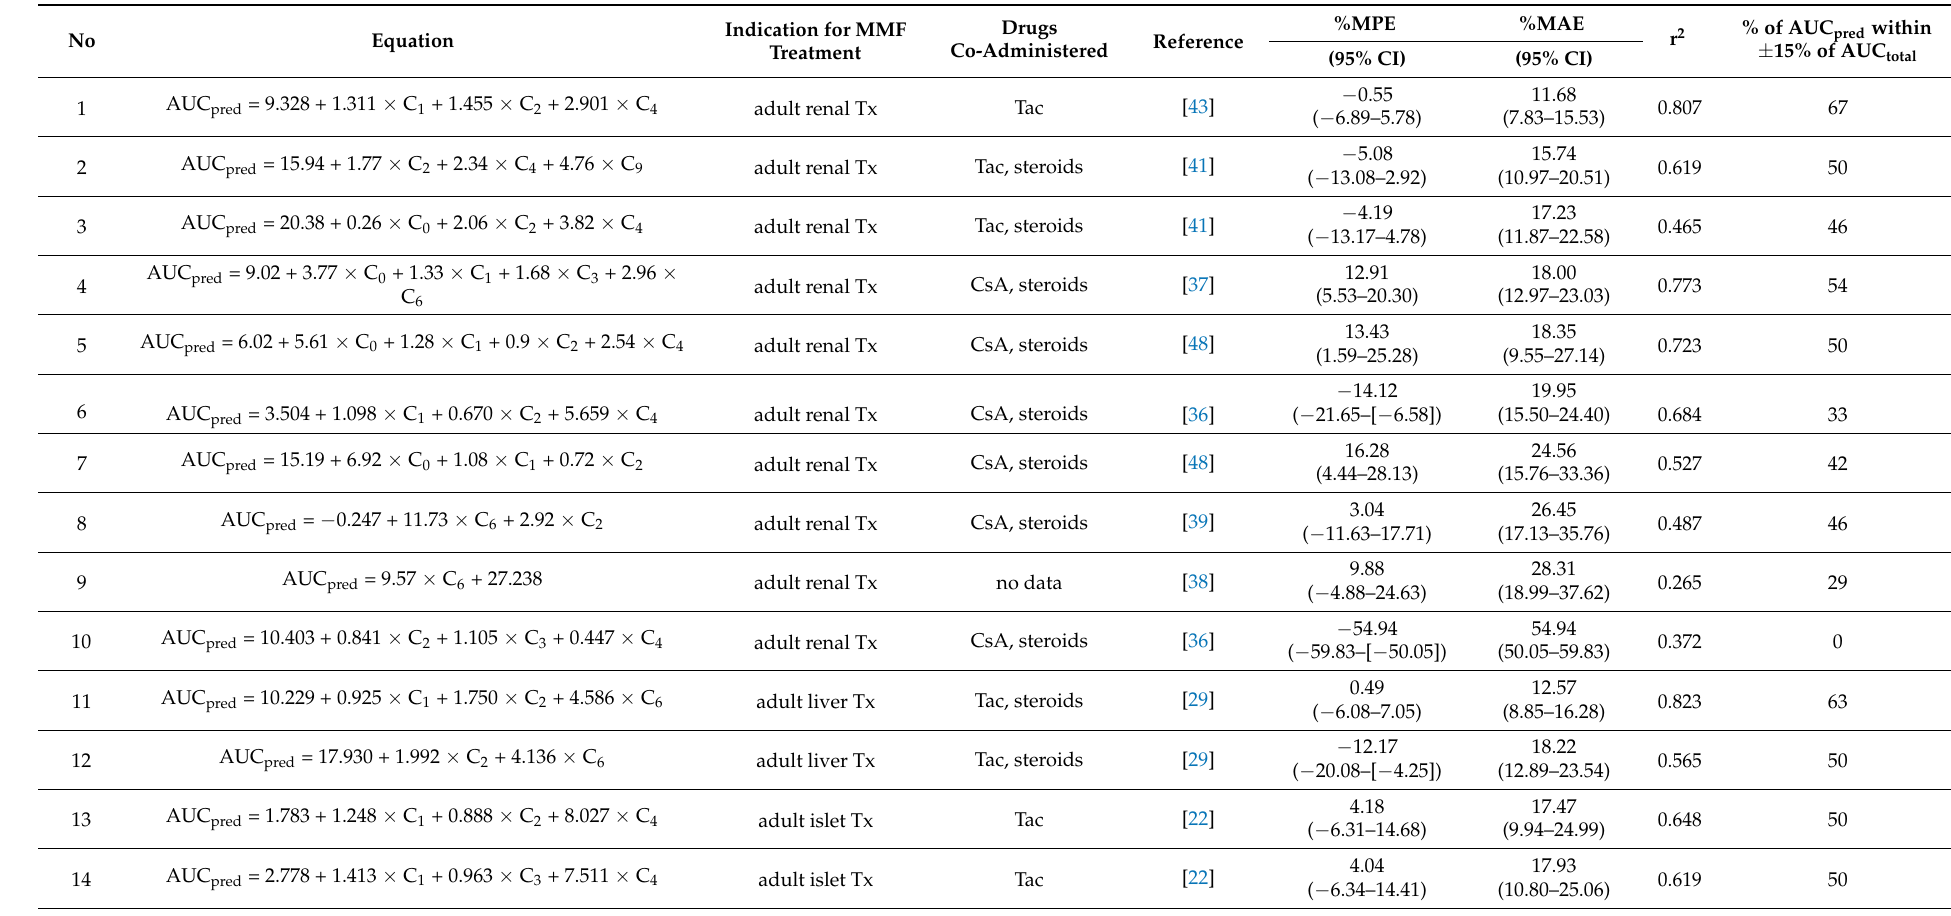
Table 2. Predictive performance of MLR-based HPLC–MPA LSSs available in the literature for estimation of MPA AUC pred in children with nephrotic syndrome treated with